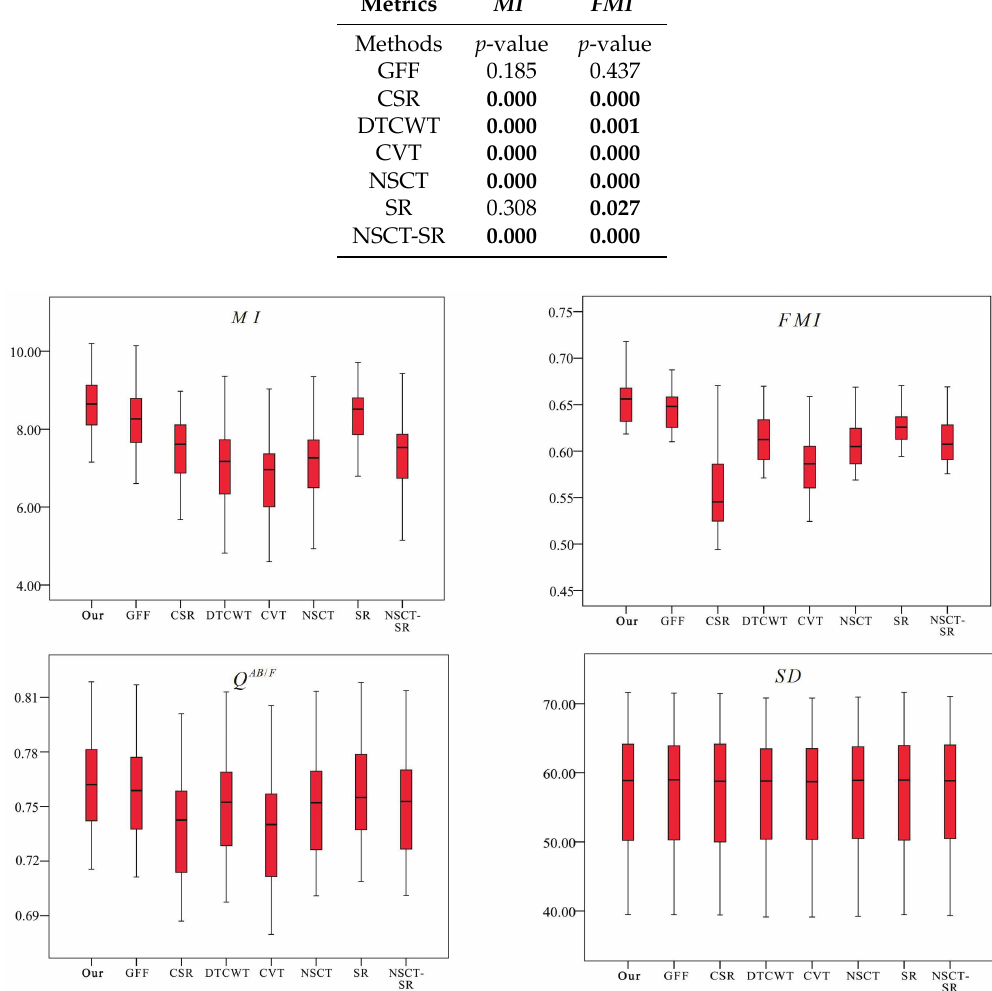
Table 5. Post hoc tests for MI and FMI for the proposed method.